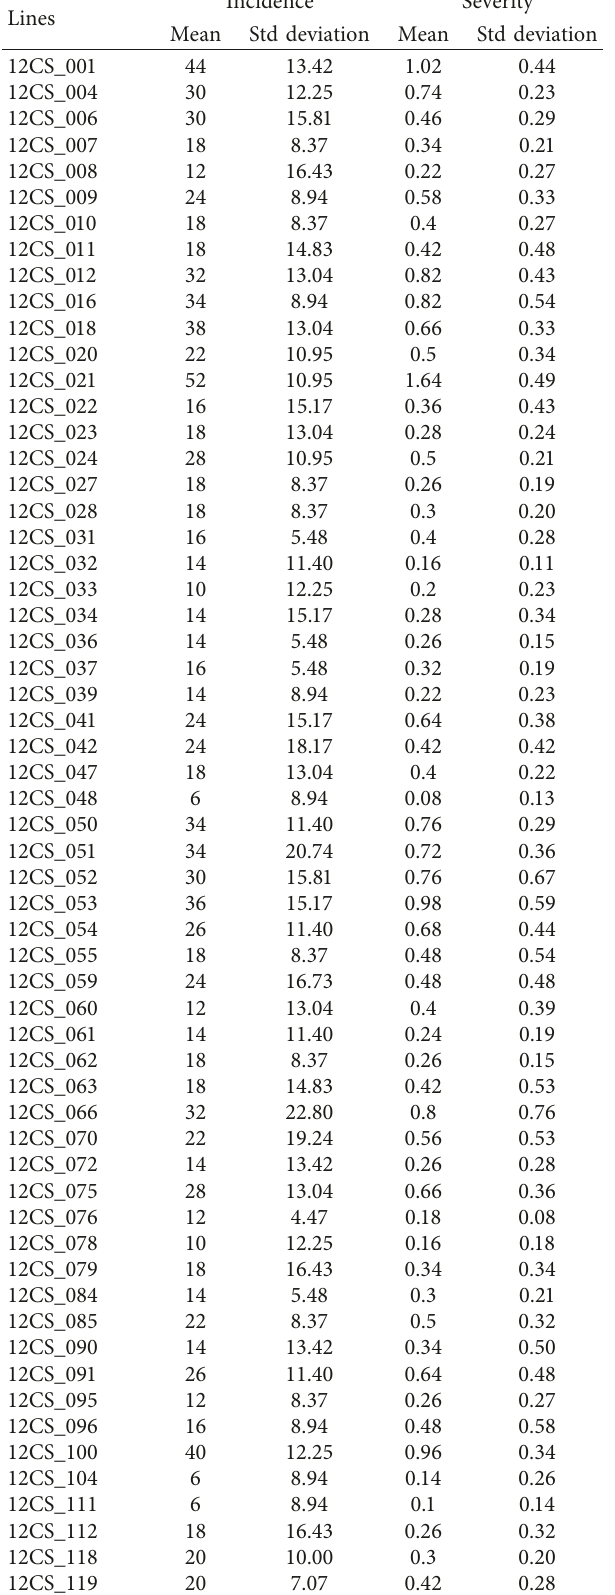
Table 3: Means of incidence and severity of the tested lines. Lines